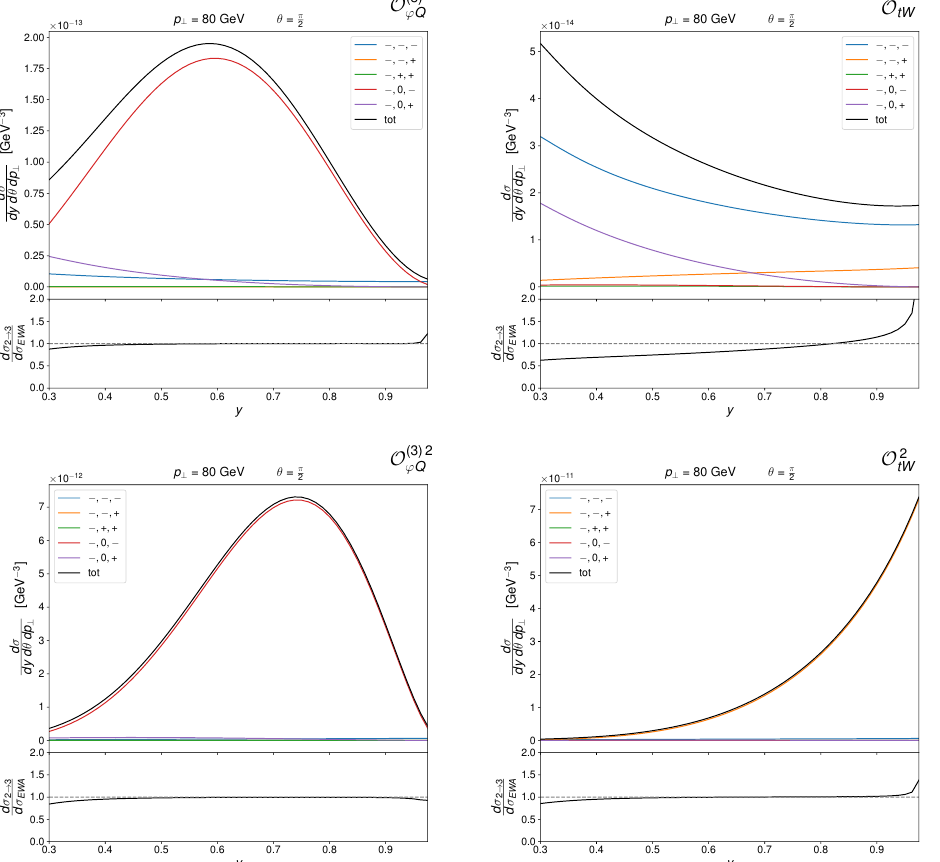
Figure 4. Plots of the intereference and square contribution in various ( (cid:21) ; (cid:21) ; (cid:21) ) helicity con- b W t (cid:12)gurations to the di(cid:11)erential cross section as a function of the hard-scattering energy fraction (3) y = p ^ s= 2 E for the operators (on the left) and (on the right). ’Q O O tW (cid:12)guration, in which the SMEFT amplitude grows linearly with energy, more or less follows the f splitting function, implying a lack of energy growth in the 2 2 interference term. ! (cid:0) It decreases with energy in absolute terms but less so than the SM, i.e a relative growth compared to the SM is still possible due to the di(cid:11)erent virtual W -polarisation state me- (3) diated by this operator. The squared contributions con(cid:12)rm this picture, with the ’Q O killed at high x by f 0 while the dipole is free to grow given the almost constant behaviour of f at high energies. Note that the squared term for is dominated by a di(cid:11)erent O tW (cid:0) W -polarisation than its interference